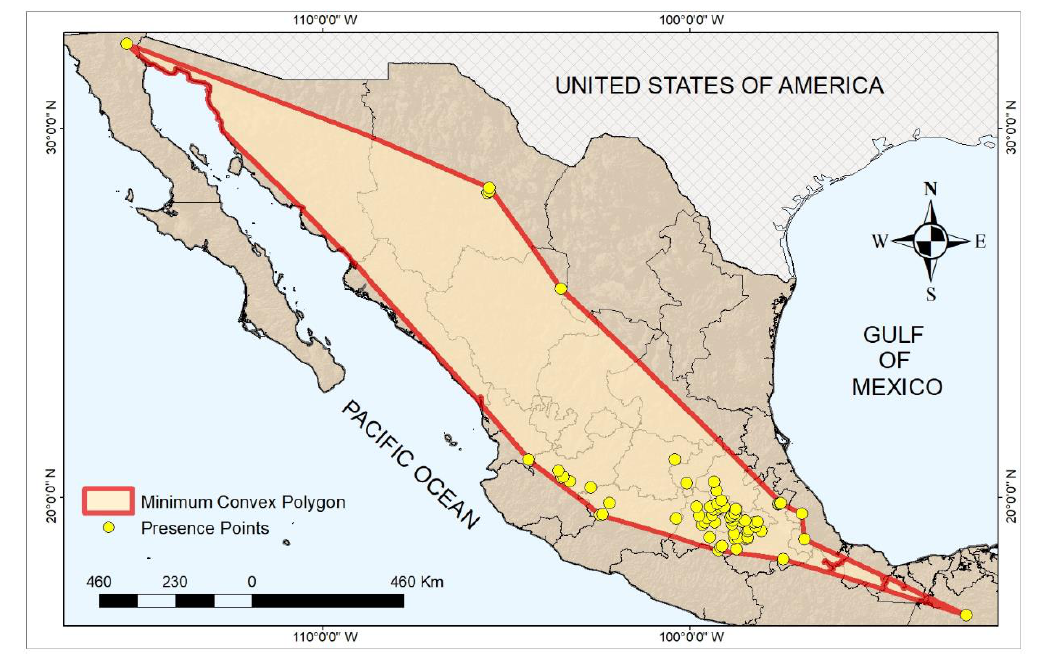
Figure 1. Minimum Convex Polygon and points of occurrence of fig crop in agricultural areas.